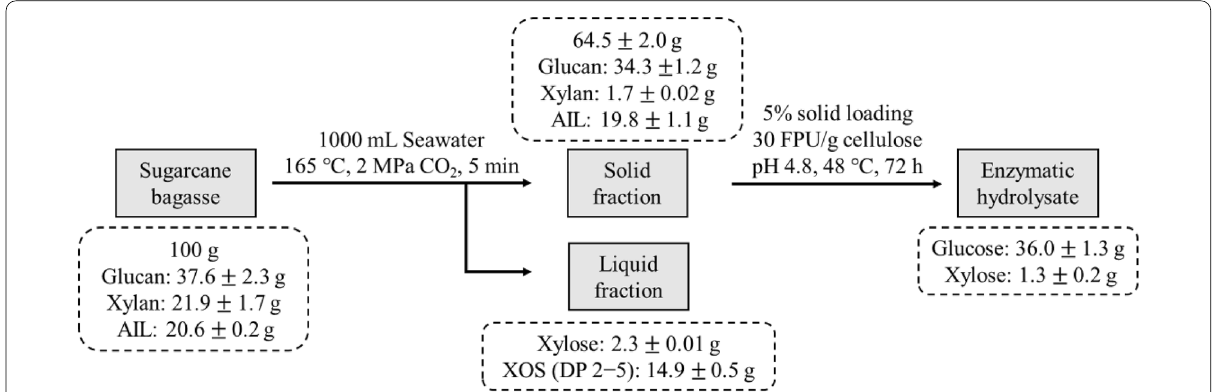
Fig. 6 Material balances for subcritical CO 2 -assisted seawater pretreatment and subsequent enzymatic